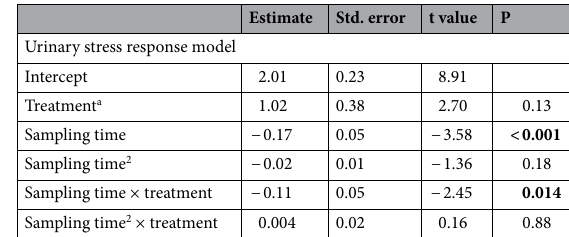
Table 2. Results of the Linear Mixed Model comparing the urinary cortisol levels between the control and test day. a Reference category for treatment was set to control. Boldface indicates significance with P < 0.05.